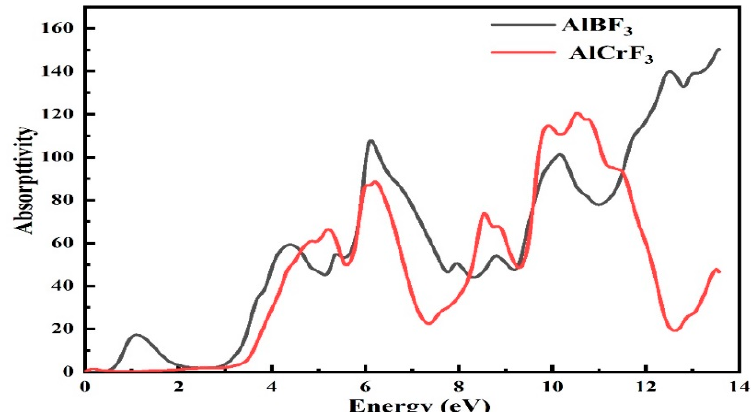
Figure 7. The Computed Absorptivity (absorption coefficient) for the fluoroperovskite AlMF 3 (M= Cr, B).